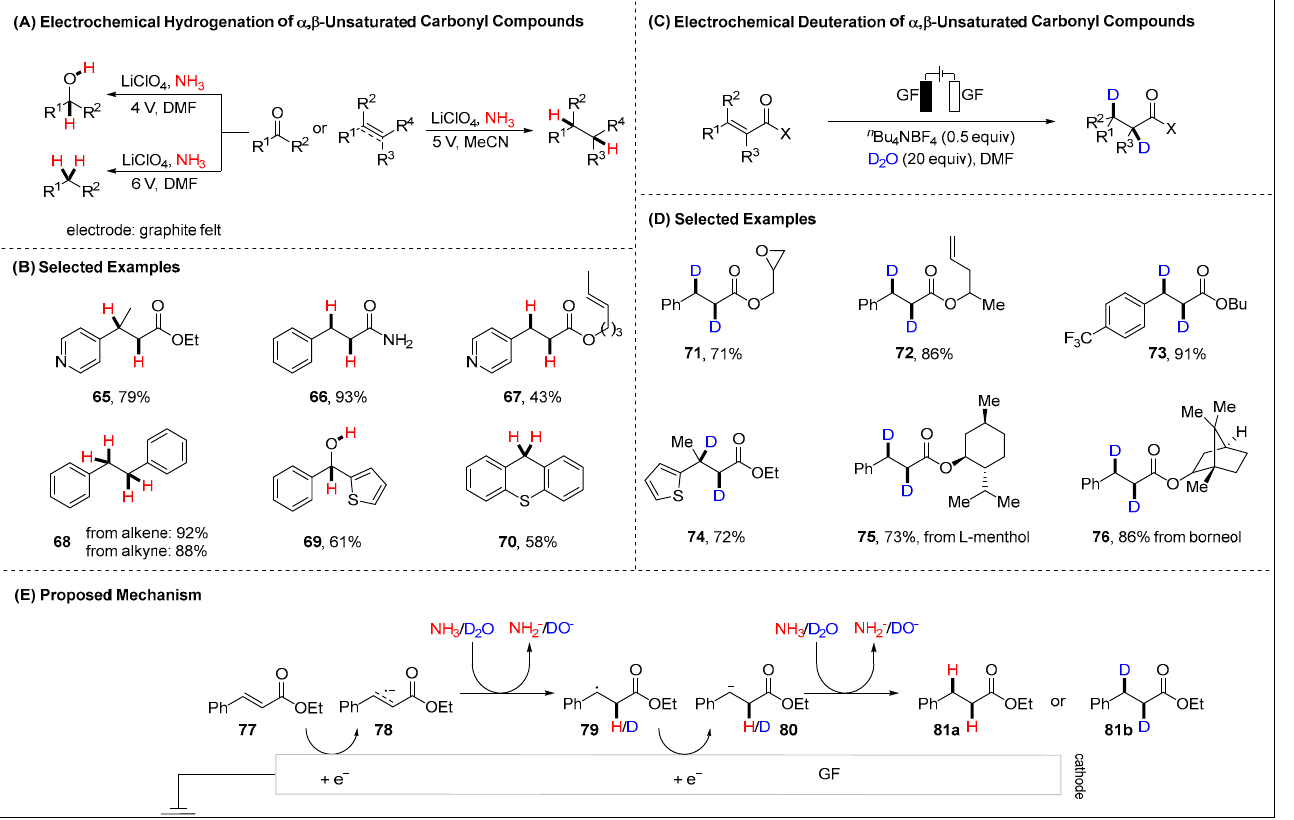
Figure 9. Electrochemical hydrogenation with gaseous ammonia or deuteration with D 2 O of alkenes, alkynes and ketones.